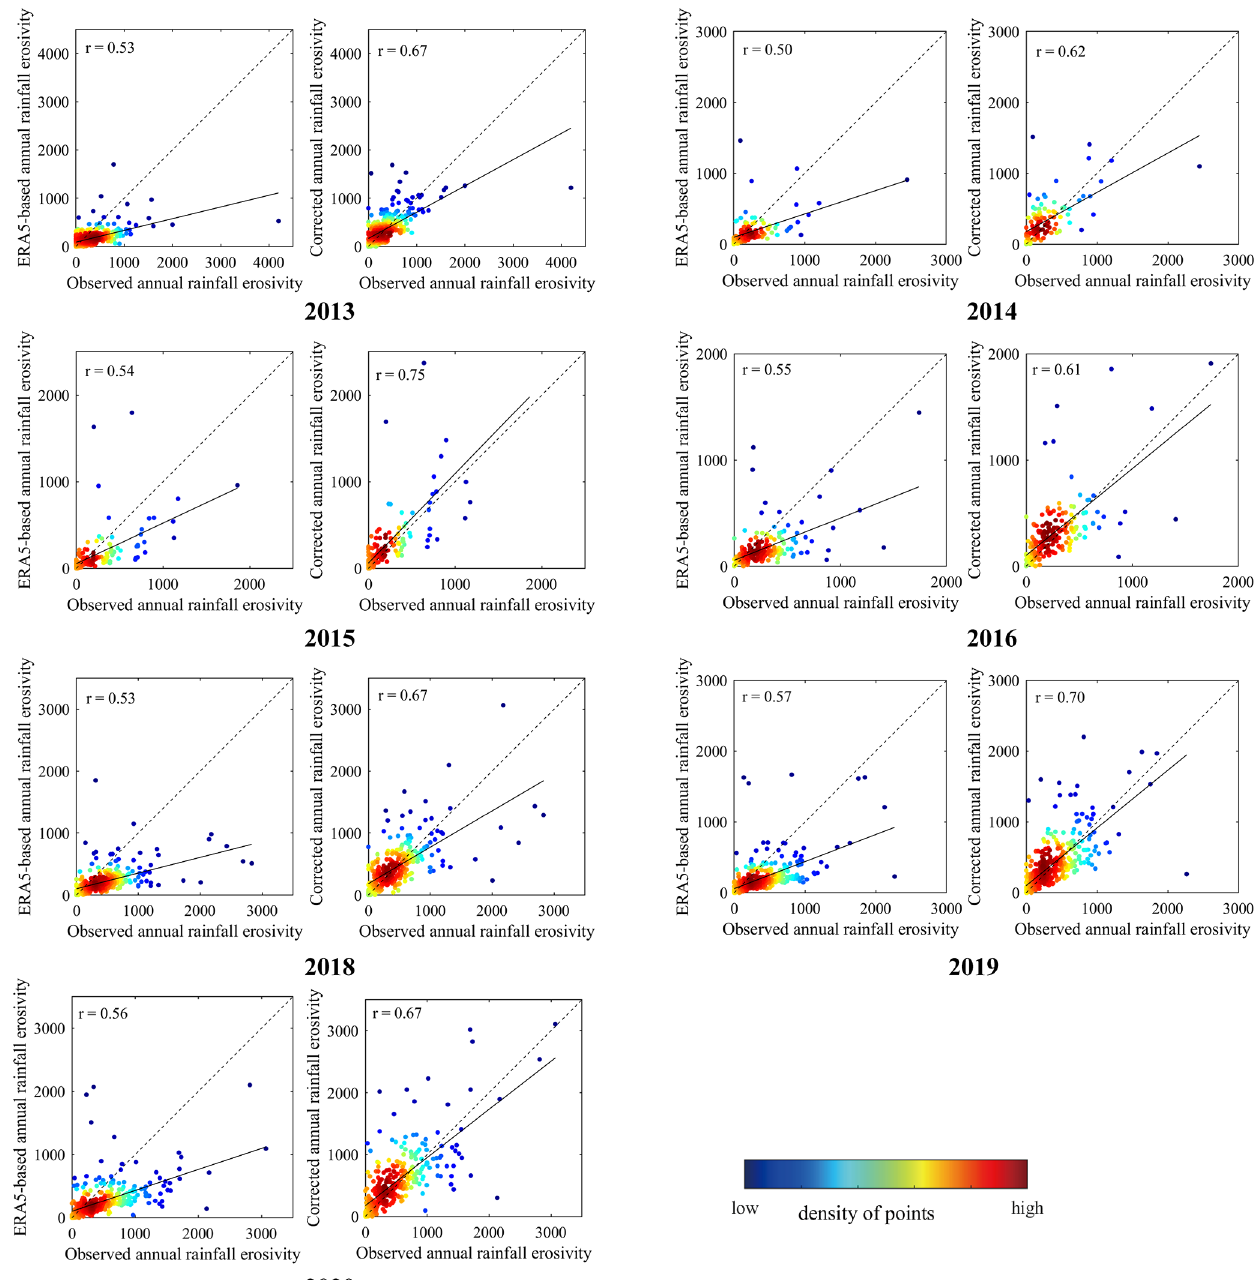
Figure 9. Comparison of ERA5-based annual rainfall erosivity (MJmmha − 1 h − 1 yr − 1 ) (left-hand graphs) and the corrected annual rainfall erosivity (right-hand graphs) with observed values in validation grids for 2013–2020 (excluding 2017). The dashed line is the result of an optimal model (with an intercept of 0 and a regression coefficient of 1). The solid black lines are the regression result. Colors of dots represent the grid